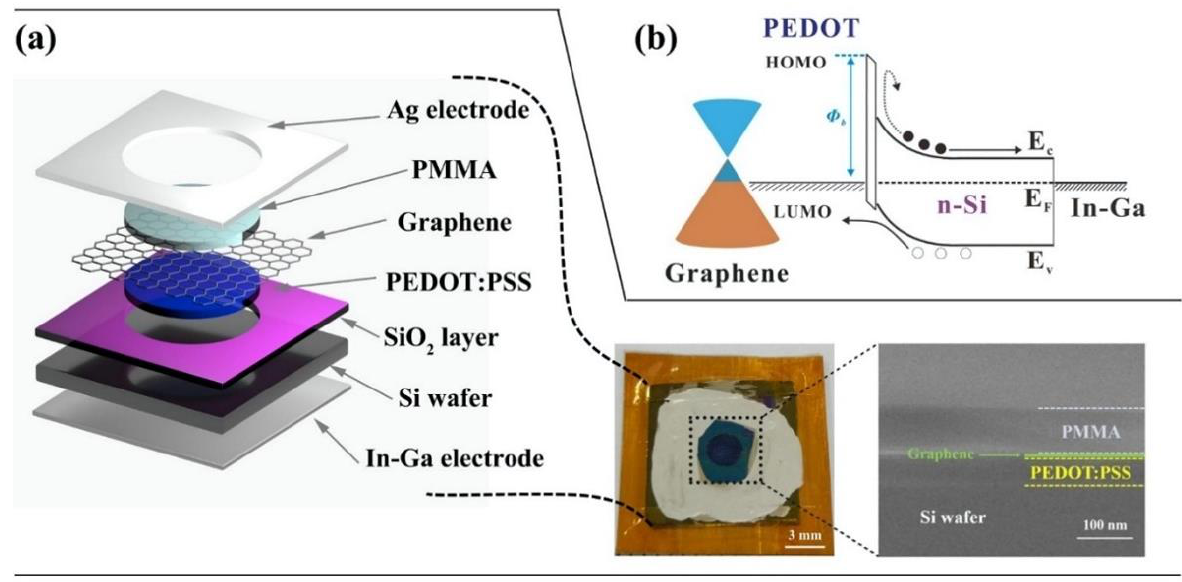
Figure 9. ( a ) Structure schematic and ( b ) energy band diagram of the PMMA/Gr/PEDOT:PSS/Si heterojunction solar cell. Reprinted with permission [88]; 2022, Elsevier.